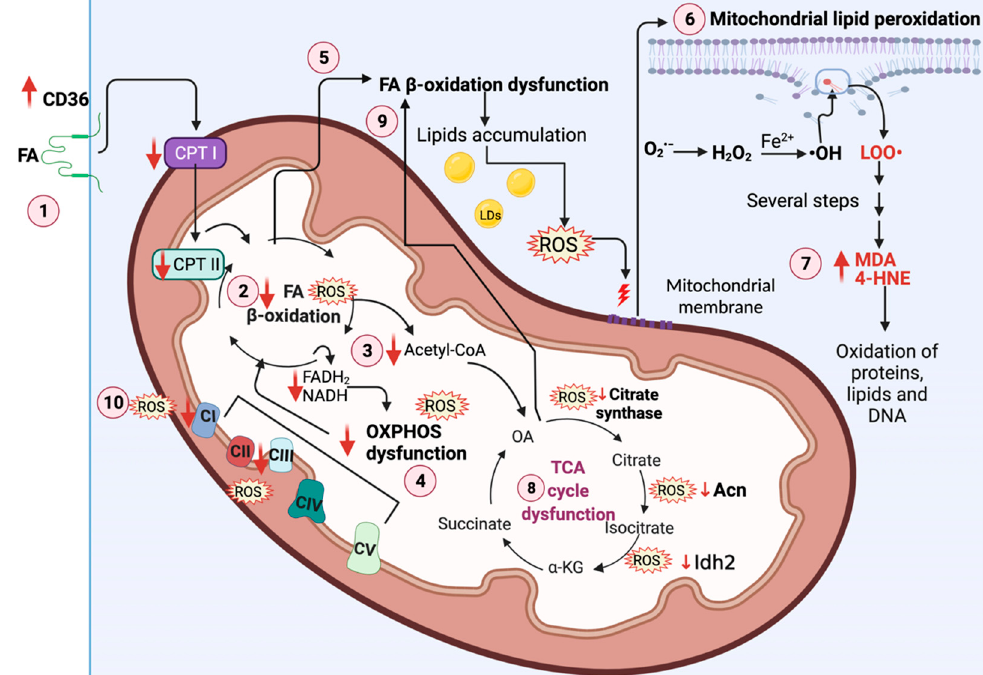
Figure 4. ROS deregulate mitochondrial metabolism in kidney diseases. (1) In renal damage, the cluster of differentiation 36 (CD36) overexpression causes a high fatty acids (FA) uptake. In addition, carnitine O -palmitoyl transferase I (CPT I) and carnitine O -palmitoyl transferase II (CPT II) are decreased. (2) ROS cause FA β -oxidation decrease, inducing (3) a tricarboxylic acid (TCA) cycle and (4) oxidative phosphorylation (OXPHOS) capacity reduction. The decrease in β -oxidation also (5) induces the accumulation of lipids and a further ROS overproduction. The latter (6) damages mitochondrial membranes by inducing mitochondrial lipid peroxidation, (7) forming the products malondialdehyde (MDA) and 4-hydroxynonenal (4-HNE). These products are highly reactive and damage other lipids, proteins, and mitochondrial DNA (mtDNA). On the other hand, (8) ROS downregulate aconitase (Acn), citrate synthase, and isocitrate dehydrogenase isoform 2 (Idh2), inducing TCA cycle dysfunction. Moreover, (9) TCA cycle impairment induces FA β -oxidation dysfunction. (10) ROS decrease CI and CIII activities, inducing β -oxidation dysfunction [111]. O 2 •− , superoxide anion radical; H 2 O 2